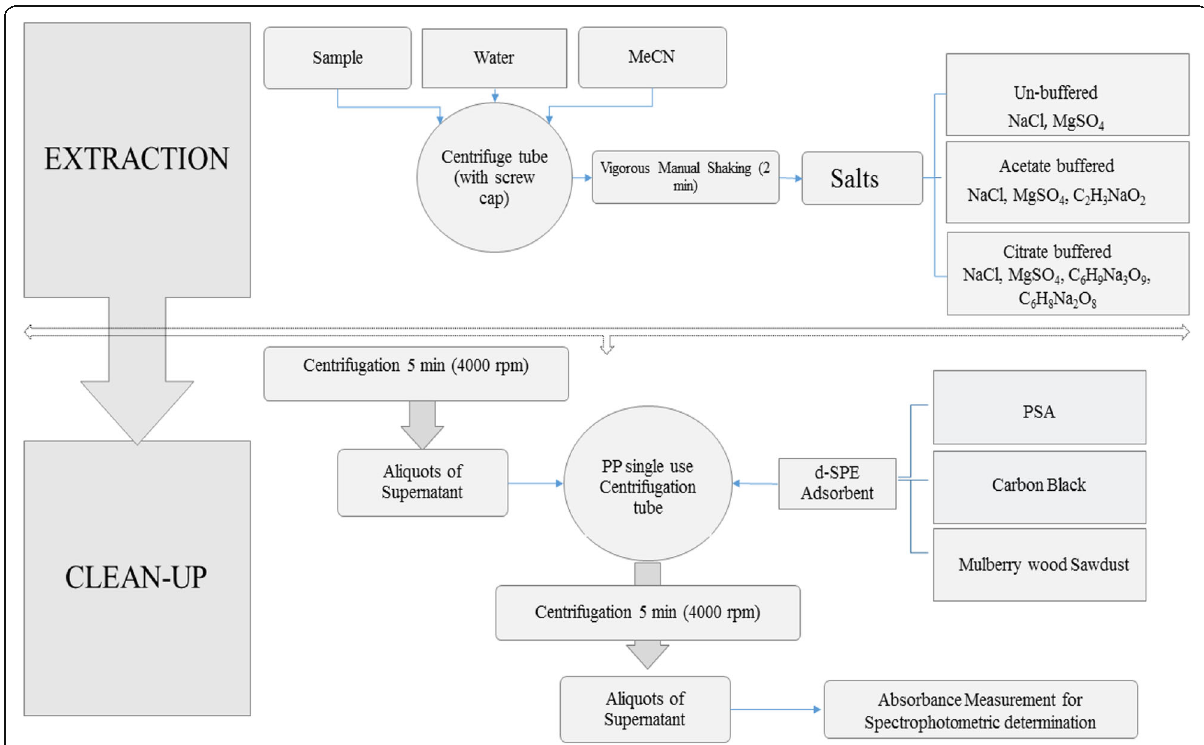
Fig. 1 Schematic representation of the QuEChERS extraction